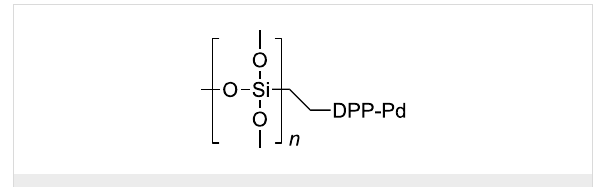
Figure 1: Chemical structure of Silia Cat